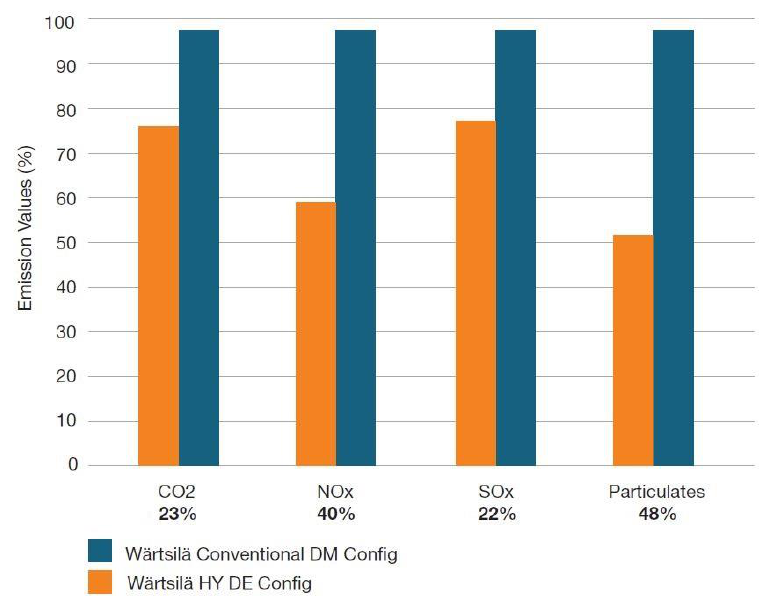
Figure 13. Emission comparison of different tug propulsion systems [70].